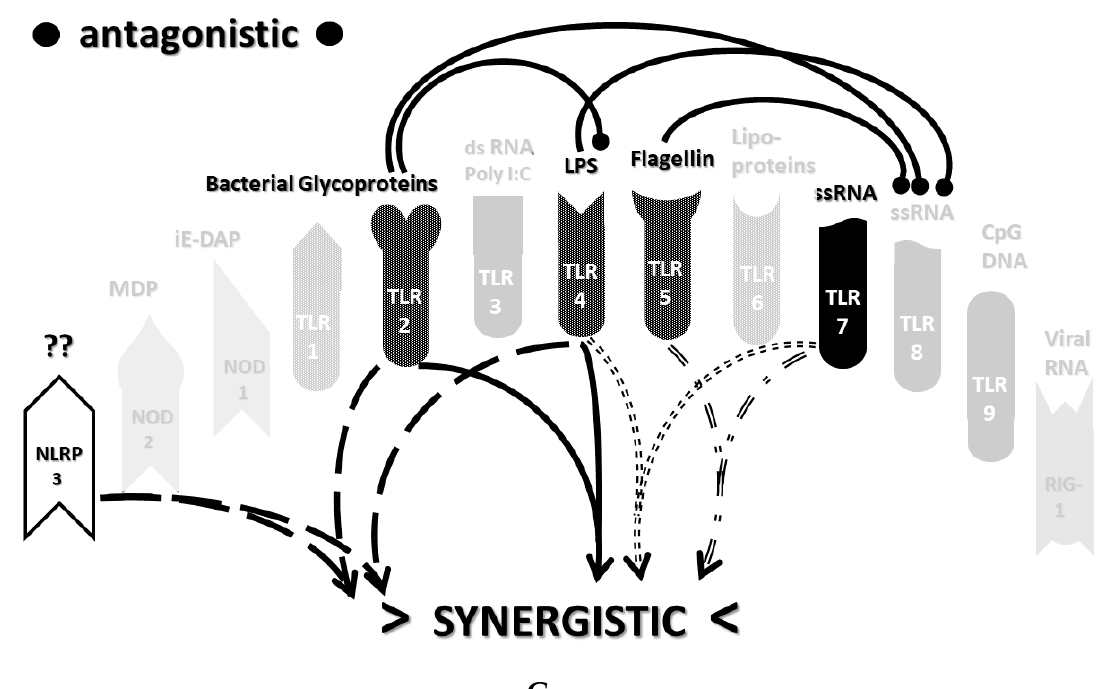
Figure 3. ( A ) Innate receptor activation pattern 2 for severe COVID-19 patients showing synergisms and antagonisms predicted from Table 1 and the model in Figure 2A,B. Receptors that are not known to be activated have been faded. The activation and increased expression of TLR2, TLR3, TLR4, TLR7, TLR9 and NLRP3 (Table 1) results in seven pairs of synergistic cytokine activation pathways. While some of these receptors may also be involved in the antagonisms shown, the fact that the receptors are known to be upregulated and expressed suggests that these antagonisms are either not active or do not outweigh the synergistic effects. The result is multiple synergisms that could drive the cytokine storm associated with severe COVID-19. See Table 1 for abbreviations. ( B ) Innate receptor activation pattern interaction network for influenza-associated ALI/ARDS predicted from Table 1 and the model in Figure 2A,B. TLR3, TLR4, TLR7, NOD2 and NLRP3 are activated, while the other receptors (faded) are not. Note that this is a different set of receptor activations, synergisms and antagonisms that were illustrated for coronaviruses in Figure 3A. The net result is five pairs of receptor synergies with only a single known antagonism on any of the activated receptors (the rest of the antagonisms acting upon receptors that are not upregulated or do not have increased expression in ALI/ARDS). These five synergies may explain how the cytokine storm is driven in ALI/ARDS and, also, why the details of the cytokine storms associated with ALI/ARDS differ in their details from those for sepsis (Figure 3C) or severe COVID-19 (Figure 3A). See Table 1 for abbreviations. ( C ) Innate receptor activation pattern interaction network for sepsis patients predicted from Table 1 and the model in Figure 2A,B. TLR2, TLR4, TLR5, TLR7 and NLRP3 are activated, while the other receptors (faded) are not. Note that this is a different set of receptor activations, synergisms and antagonisms from those illustrated for coronaviruses in Figure 3A or for the influenza A virus in Figure 3B. The net result is five pairs of receptor synergies with only a single known antagonism on any of the activated receptors (the rest of the antagonisms acting upon receptors that are not upregulated or do not have increased expression in sepsis). These five synergies may explain how the cytokine storm is driven in sepsis and, also, why the details of the cytokine storms associated with sepsis differ in their details from those for influenza-associated ALI/ARDS (Figure 3B) or severe COVID-19 (Figure 3A). See Table 1 for